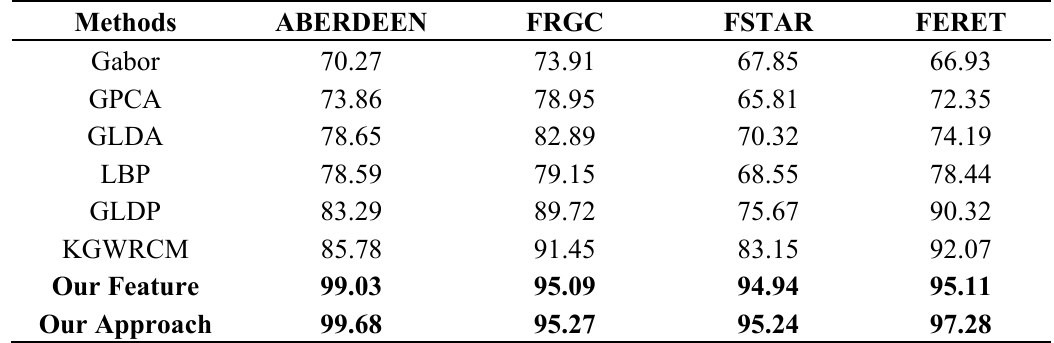
Table 2. The Recognition Rate (%) based on ABERDEEN, FRGC, FSTAR and FERET Databases.